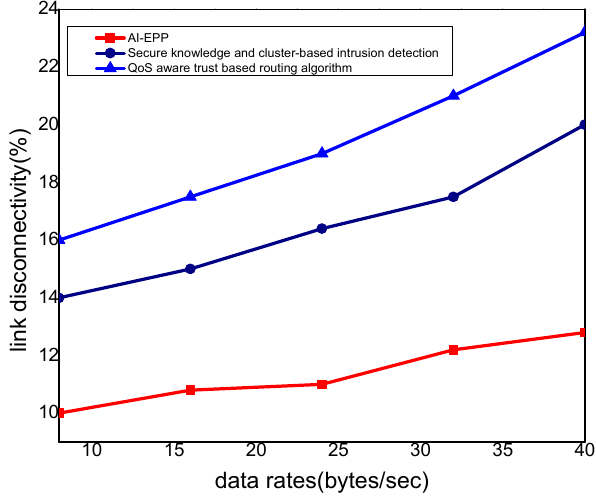
Figure 13. Link disconnectivity comparison using simulations with varying number of nodes.